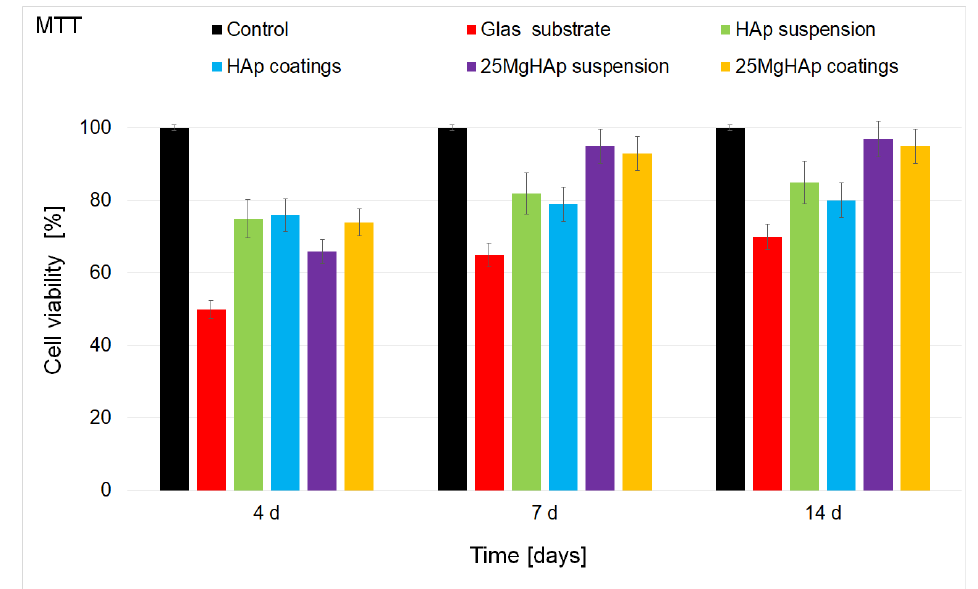
Figure 18. MTT assay for the viability of hOB cells cultured on glass substrate before coating, HA coating, 25MgHAp coating, HAp dispersions, and 25MgHAp dispersions at various incubation periods.